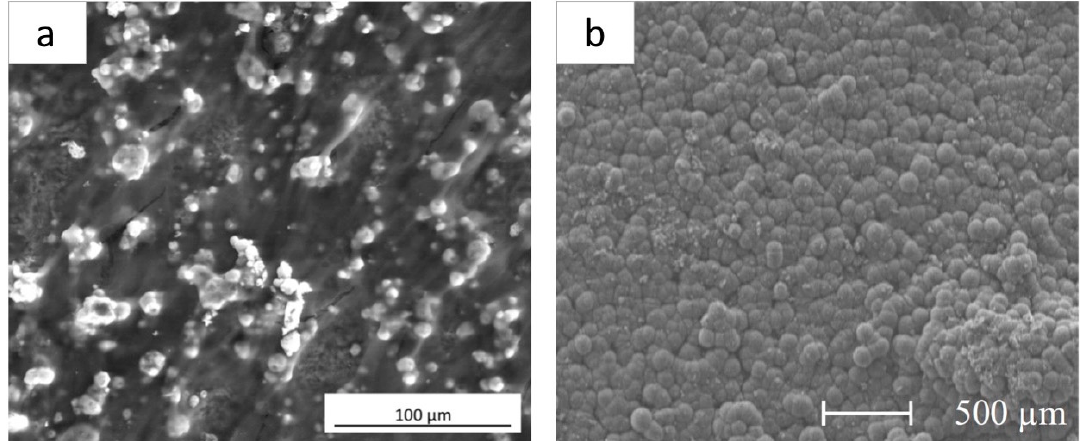
Figure 5. SEM images of cells grown on: ( a ) sphene-coated CpTi substrate after 21 days of culture in osteogenic differentiation medium; from Elsayed et al., 2018 [37]; ( b ) bioceramic coating composed of diopside, bredigite, and fluoridated hydroxyapatite deposited on Mg alloy (AZ91) after seven days of culture; modified from Razavi et al., 2018 [66].